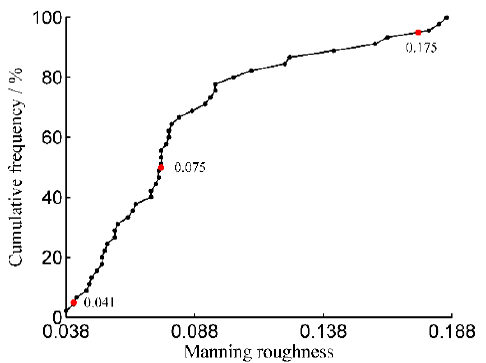
Figure 3. Cumulative frequency of Manning’s roughness for all closed-end furrow irrigation experiments.